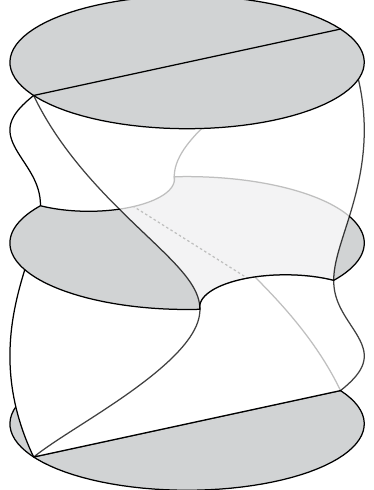
Figure 4 . The BTZ black hole in sausage coordinates from t = (cid:0) (cid:25)= 2 to t = (cid:25)= 2. The fundamental domain of the black hole is illustrated as the grey shaded region t = 0. The two white surfaces represent the development of the two glued geodesics. The solution typically has two event horizons on a constant-time slice. The event horizons coalesce at t = 0: this is indicated with the dashed line running between the two identi(cid:12)ed geodesics. This divides the spacetime into two disconnected pieces each with their own boundary at in(cid:12)nity and